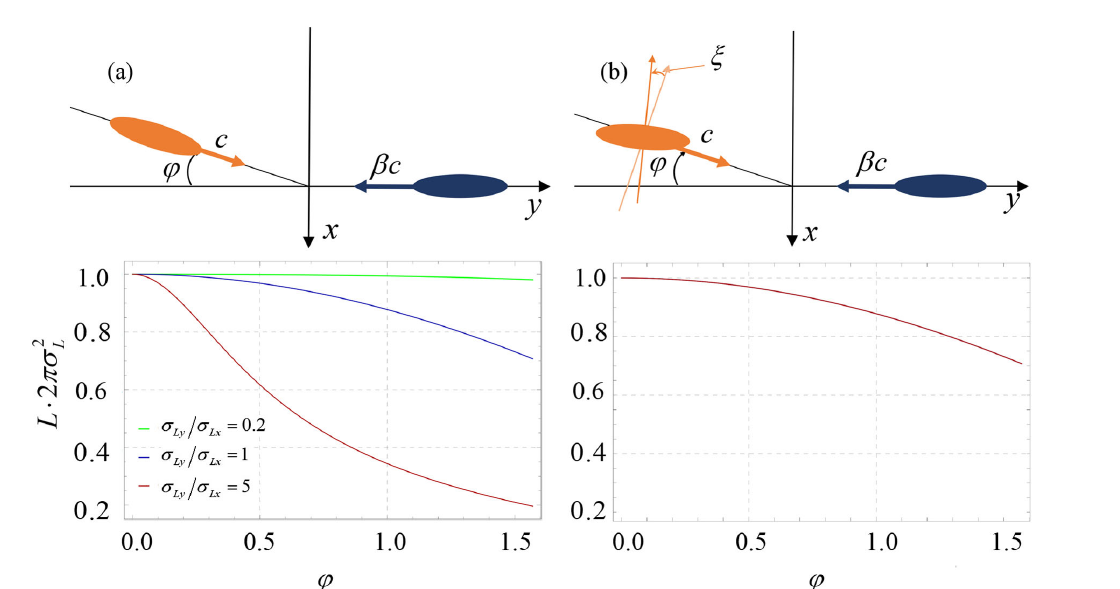
FIG. 5. Dependence of the luminosity on the noncollinearity angle φ for in the case of scattering of the laser pulse on the electron bunch with negligible sizes ( σ e → 0 ) for various lengths of the pulse σ Ly : (a) — left — the laser pulse has perpendicular front ( ξ ¼ 0 ), (b) — right — the front of the laser pulse is tilted, ξ ¼ − φ = 2 (optimal angle ξ